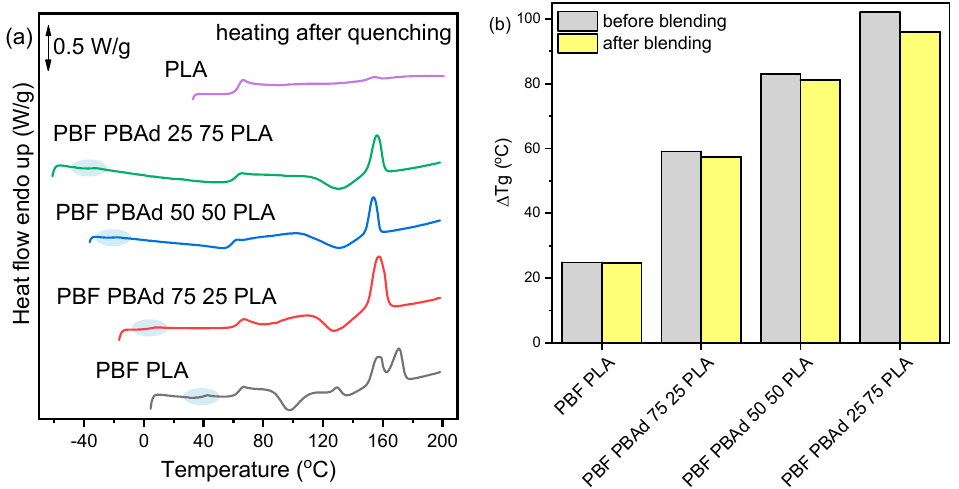
Figure 4. ( a ) DSC scans of the blends during heating after quenching at a rate of 20 °C/min and ( b ) Δ T g values of the blend’s components before and after the melt blending.